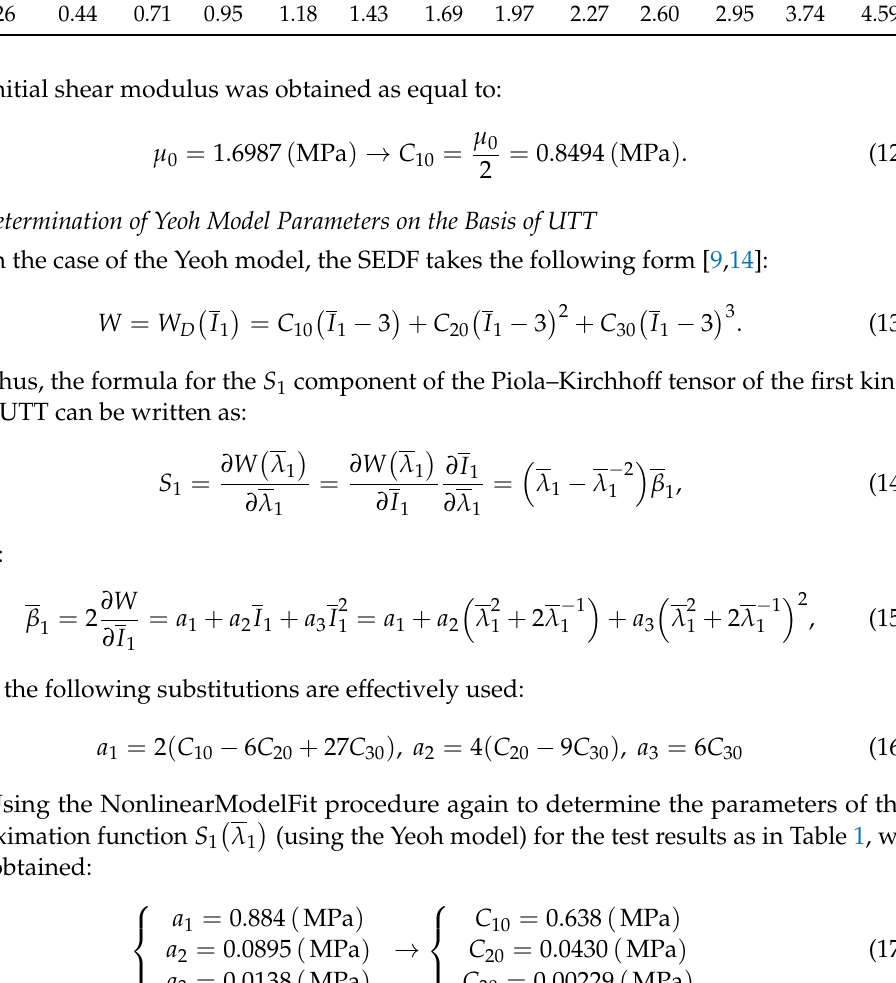
Table 1. The results of experimental results of UTT used to determine the material parameters of the hyperelasticity models. Elongation λ 1 (-) 1.00 1.01 1.05 Stress S 1 (MPa) 0.00 0.07